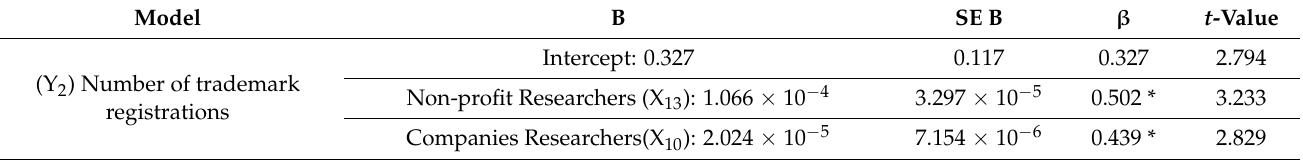
Table 4. Multiple Regression Model for the Number of Trademark